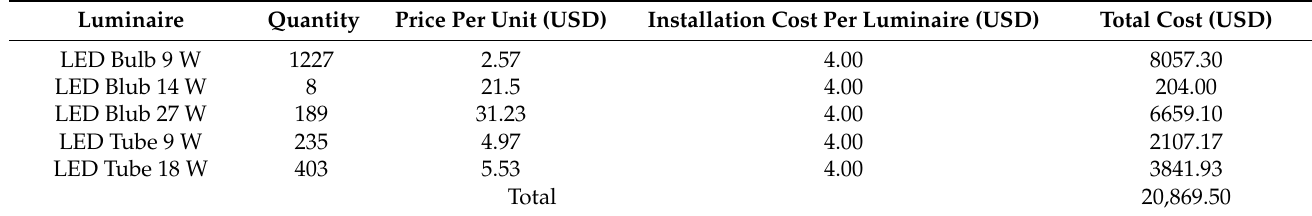
Table 18. Equipment and installation cost of lighting systems.